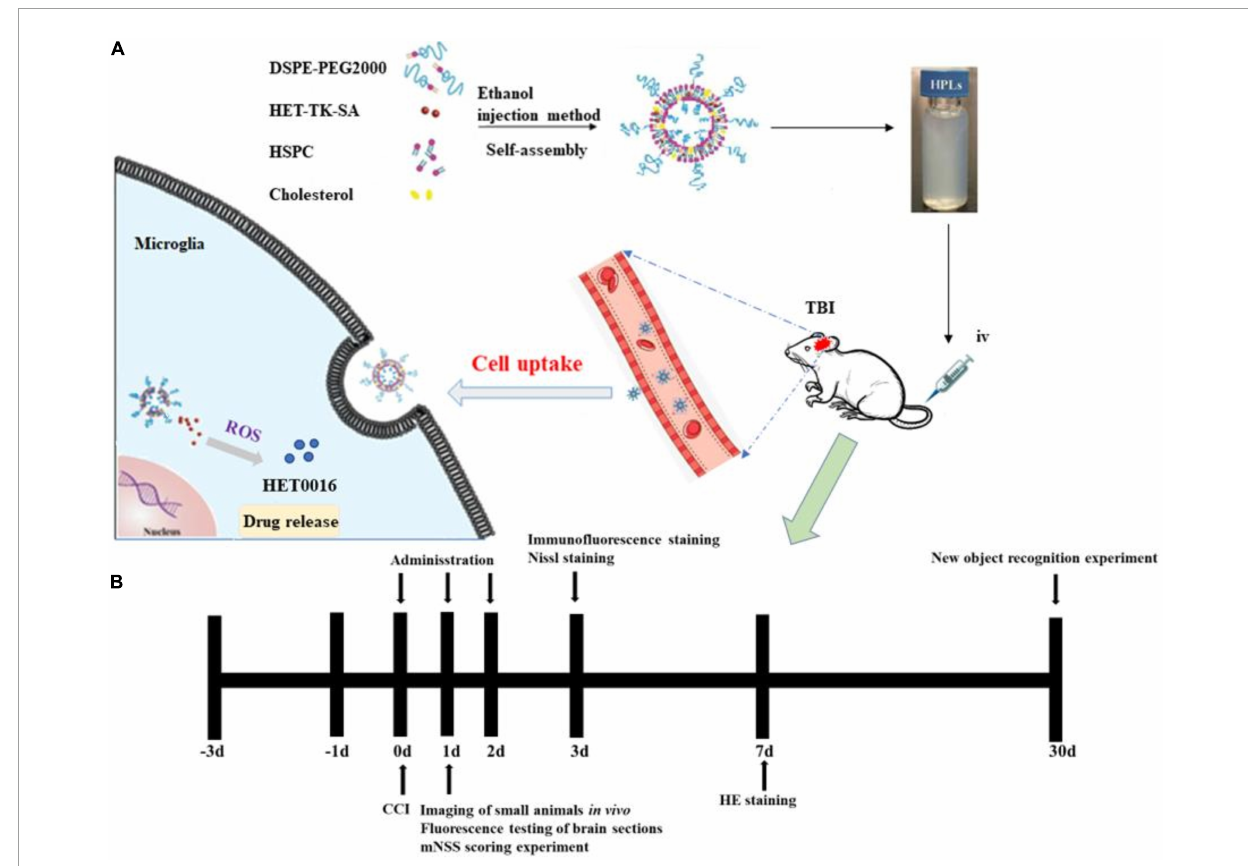
FIGURE1 HPLs preparation and protocol schedule. (A) Schematic diagram of HET0016 prodrug liposomes (HPLs) from preparation to cellular uptake. (B) Experimental protocol and